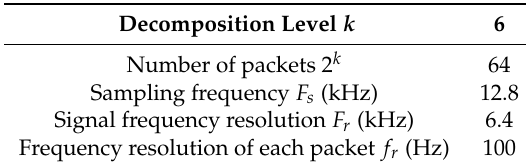
Table 1. Decomposition level and frequency